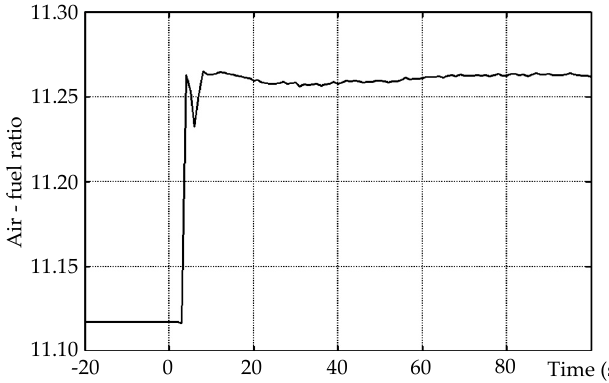
DMC u . Figure 7. Response of air–fuel ratio in 1000 MW plant due to step increase of (cid:101) u a a